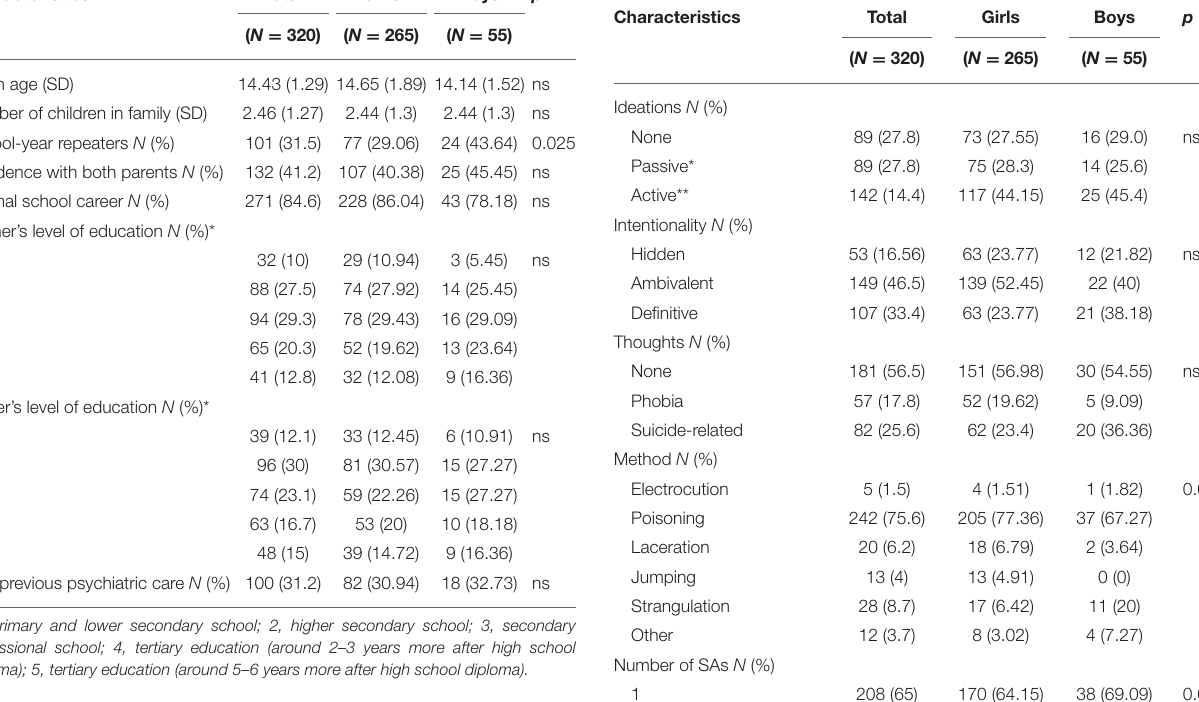
TABLE 2 | Characteristics of suicidal behaviors evaluated on the Columbia-suicide severity rating scale and comparisons by gender.